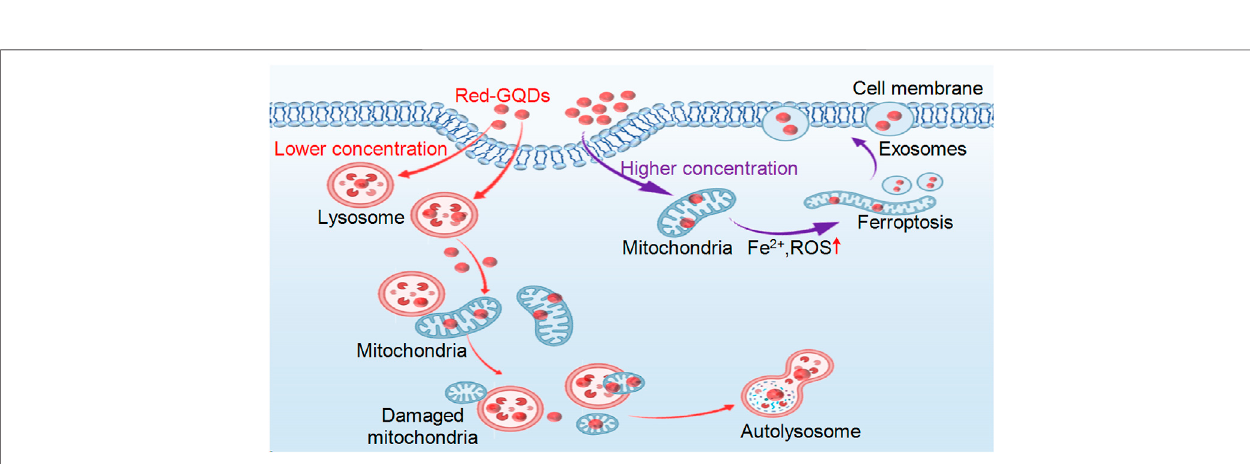
Frontiers in Pharmacology |